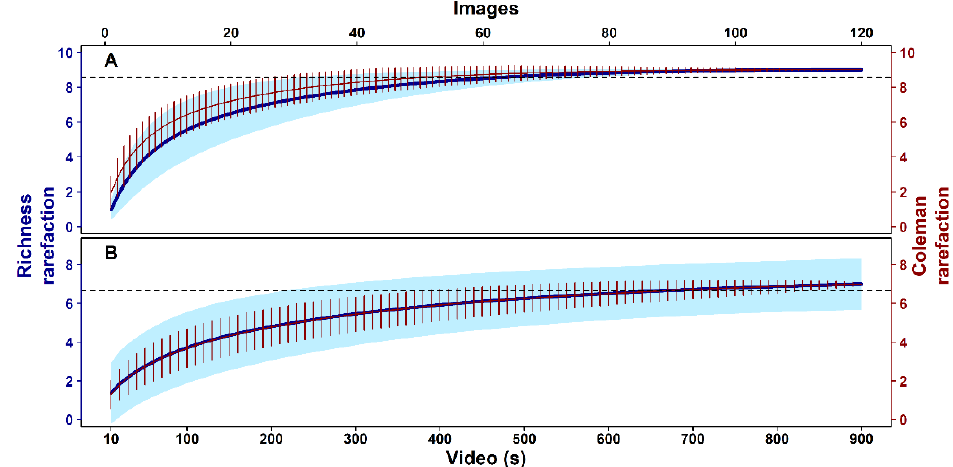
Figure 13. Comparison of species rarefaction curves for the OBSEA ( A ) and the crawler ( B ) cameras. Richness rarefaction (blue curve) with 95% confidence interval (light blue band) and Coleman’s rarefaction (red curve with ± SD red bars) for ( A ) OBSEA, with added samples from images every 30 min; and ( B ) crawler, with samples from video segments of 10 s. The horizontal dashed line corresponds to 95% of the estimated number of species for each platform.